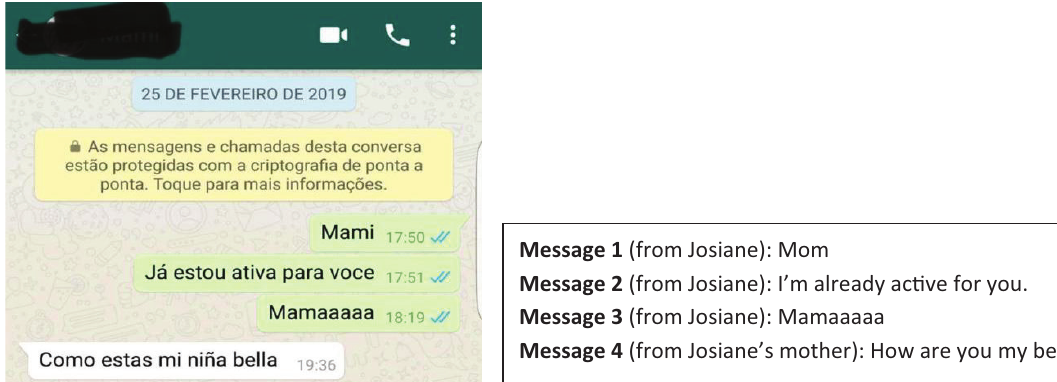
Figure 1. Screenshot of the WhatsApp communication between Josiane and her